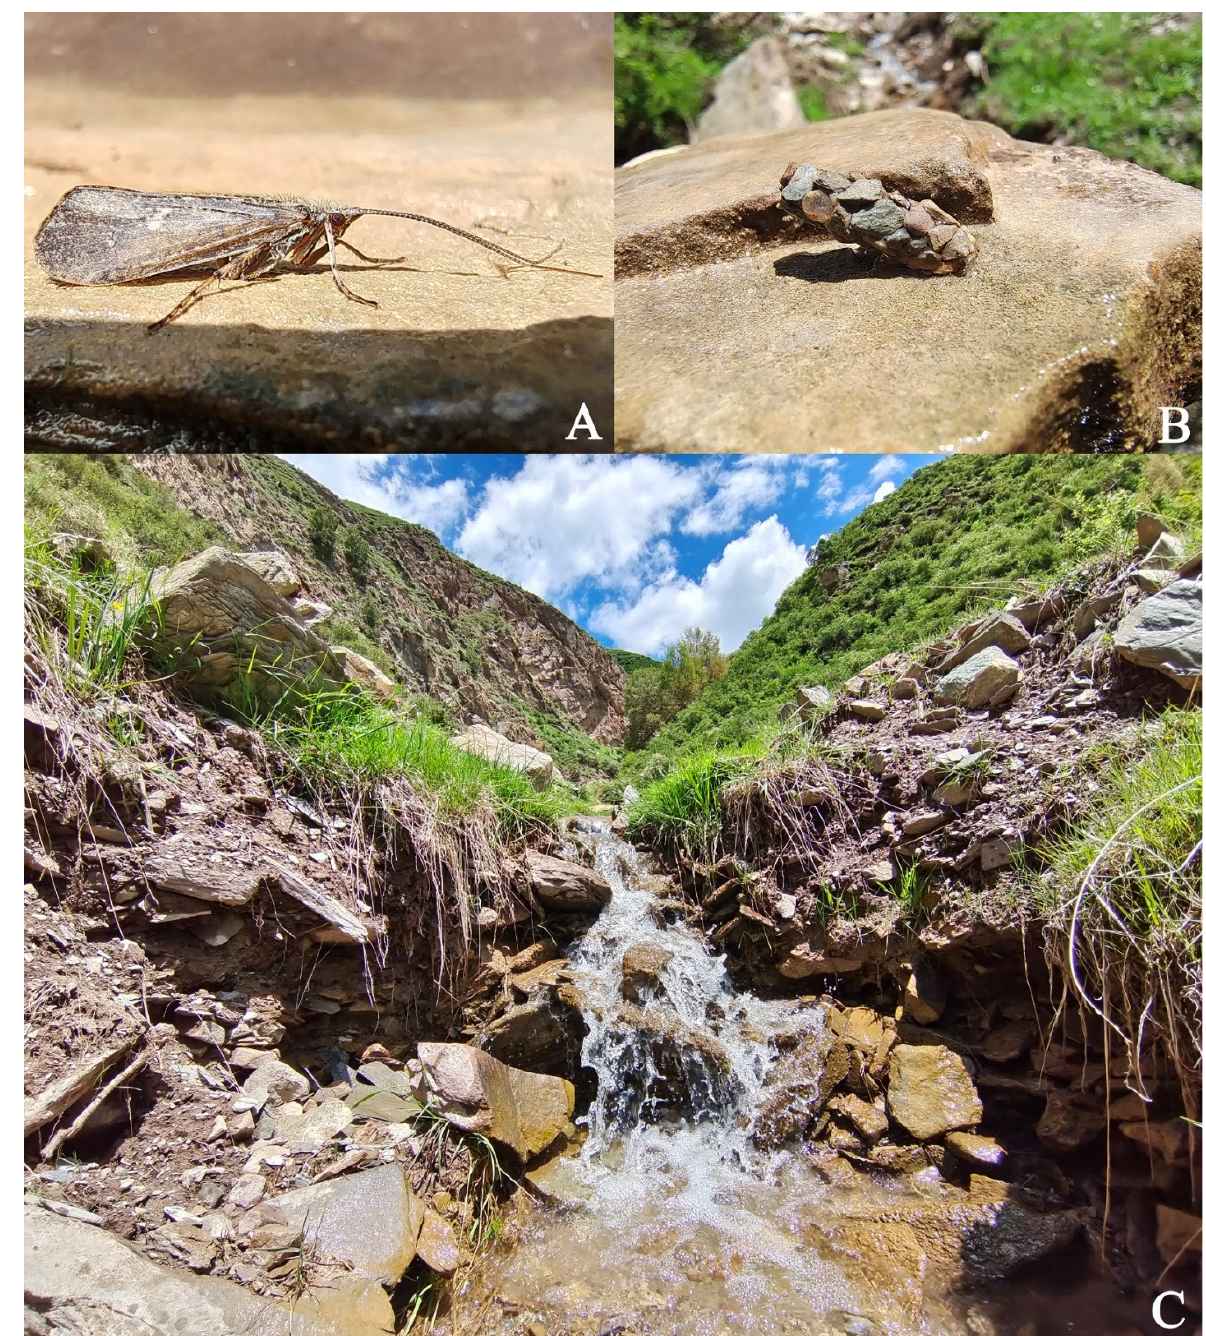
Figure 1. Ecological photos. ( A ) Male adult; ( B ) pupal case; and ( C ) habitat.